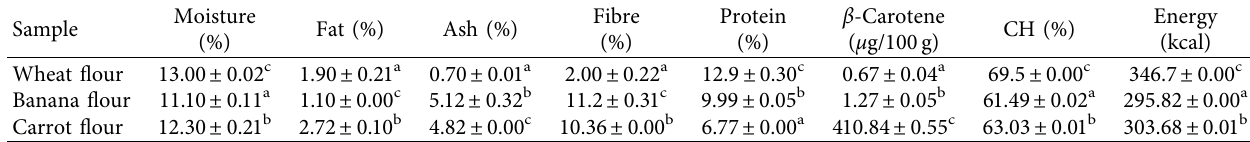
Table 3: Proximate composition for raw material.